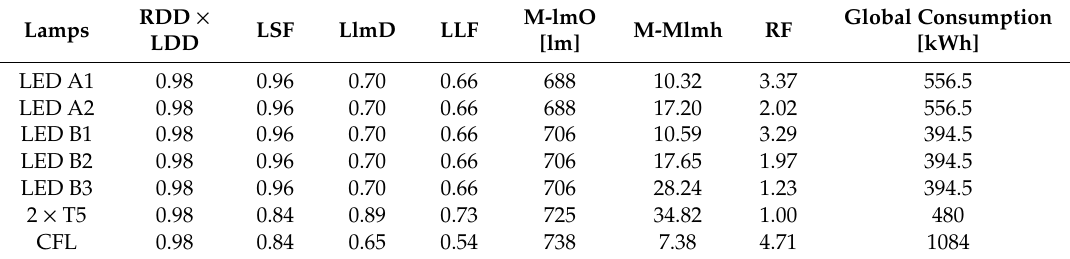
Table 2. Lamp light loss factor (LLF), maintained lumen output (M-lmO), functional unit and